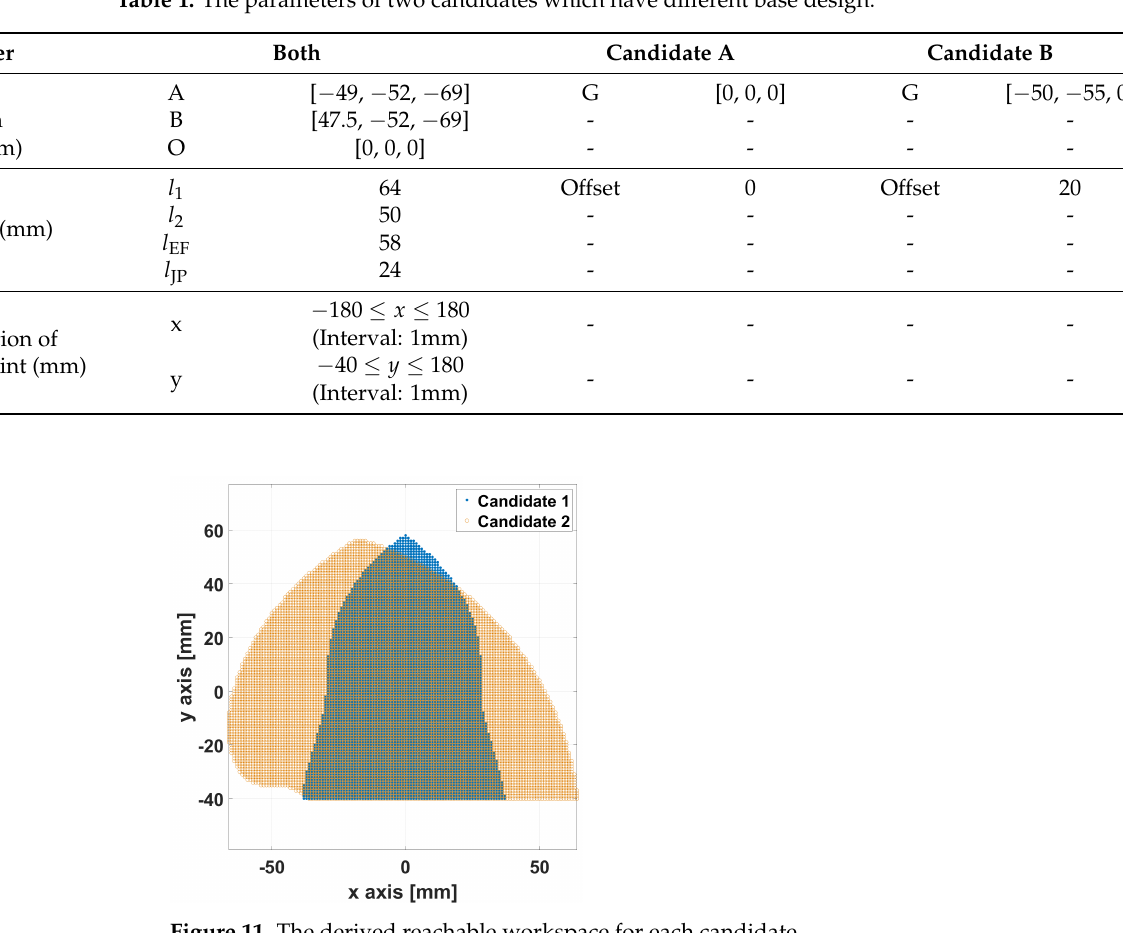
Table 1. The parameters of two candidates which have different base design.